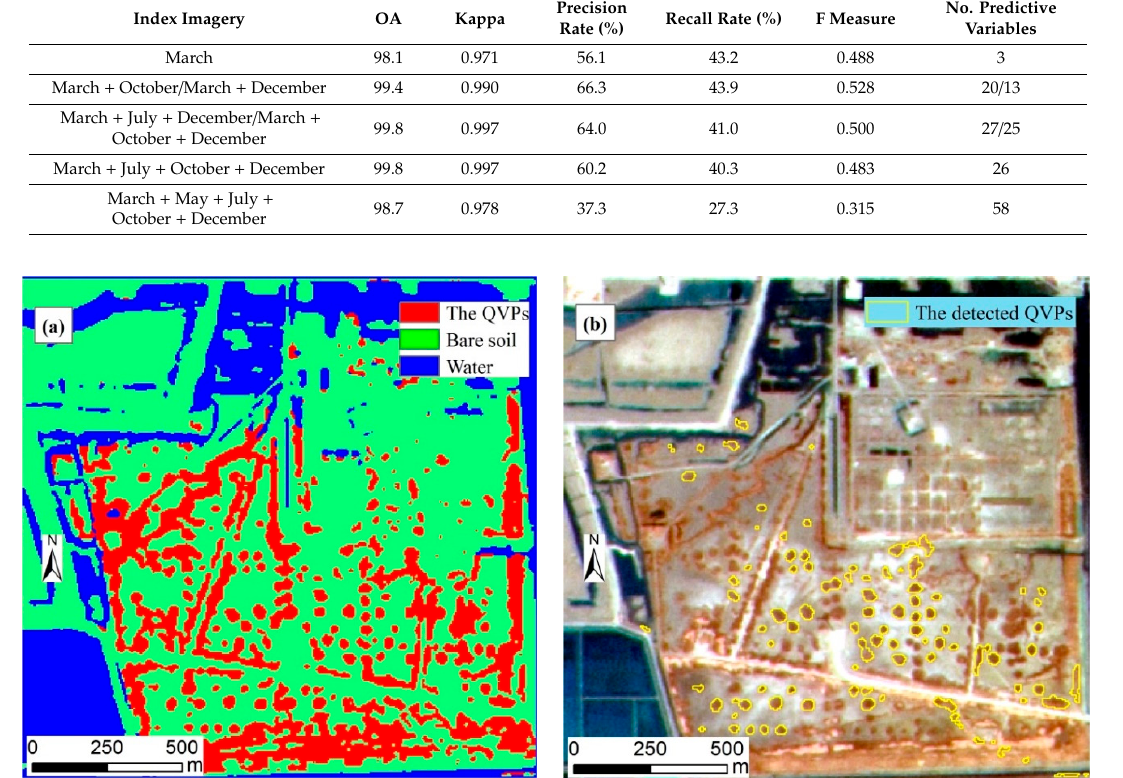
Figure 12. ( a ) Classification result of the QVPs, bare soil, and water area using the random forest classifier with the March–December combined images; ( b ) The final detected QVPs of Figure 10a using the thresholds of area (less than 3000 m 2 ) and perimeter/area (less than 0.54).